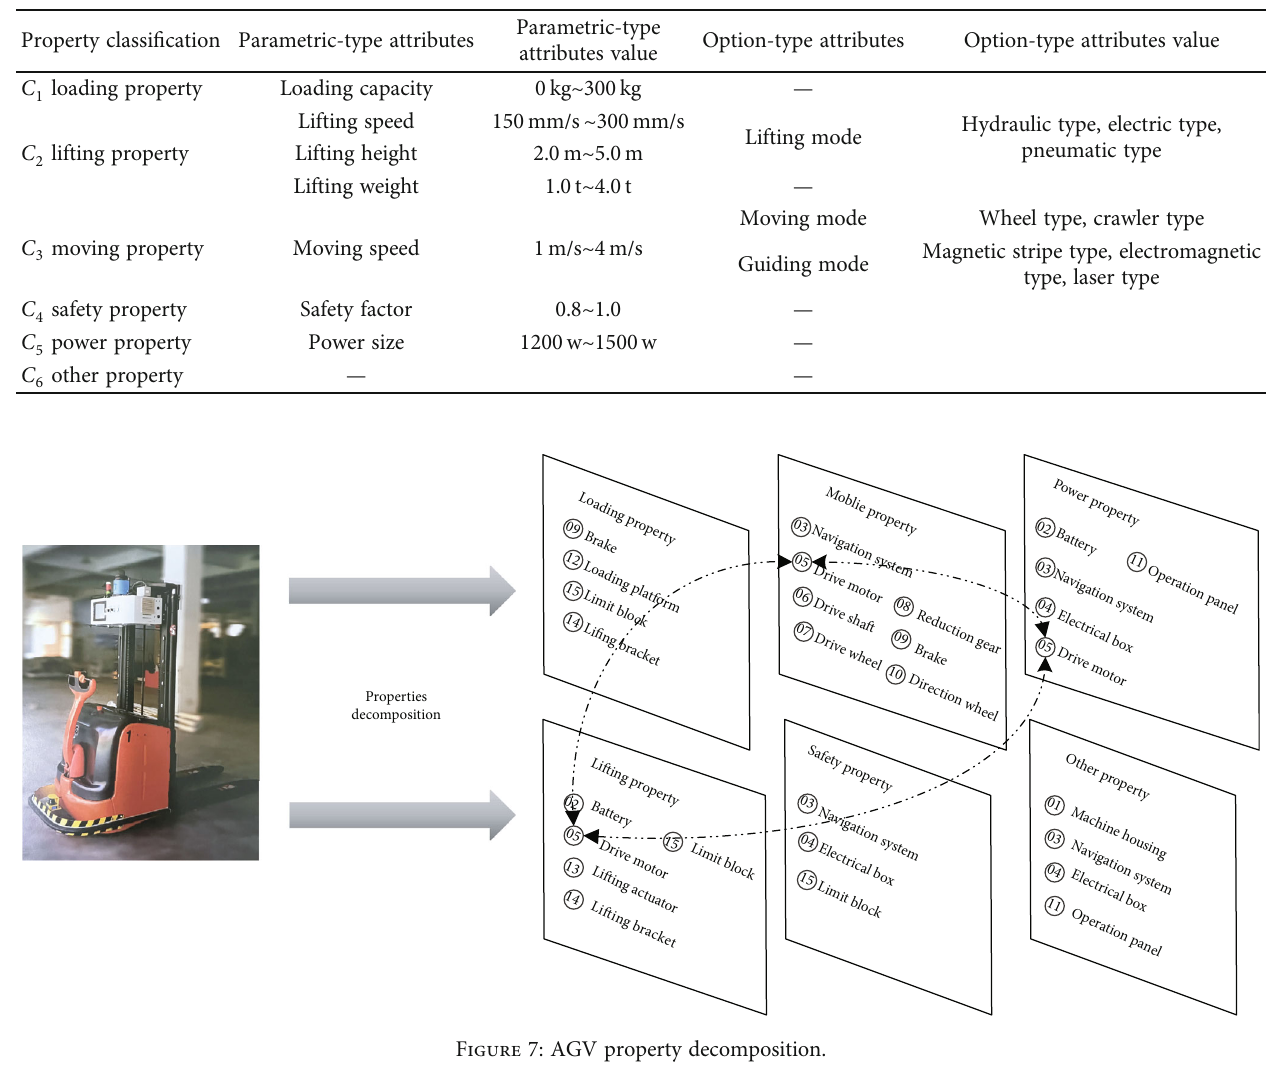
Table 6: Property classi fi cation of the stack-type AGV.